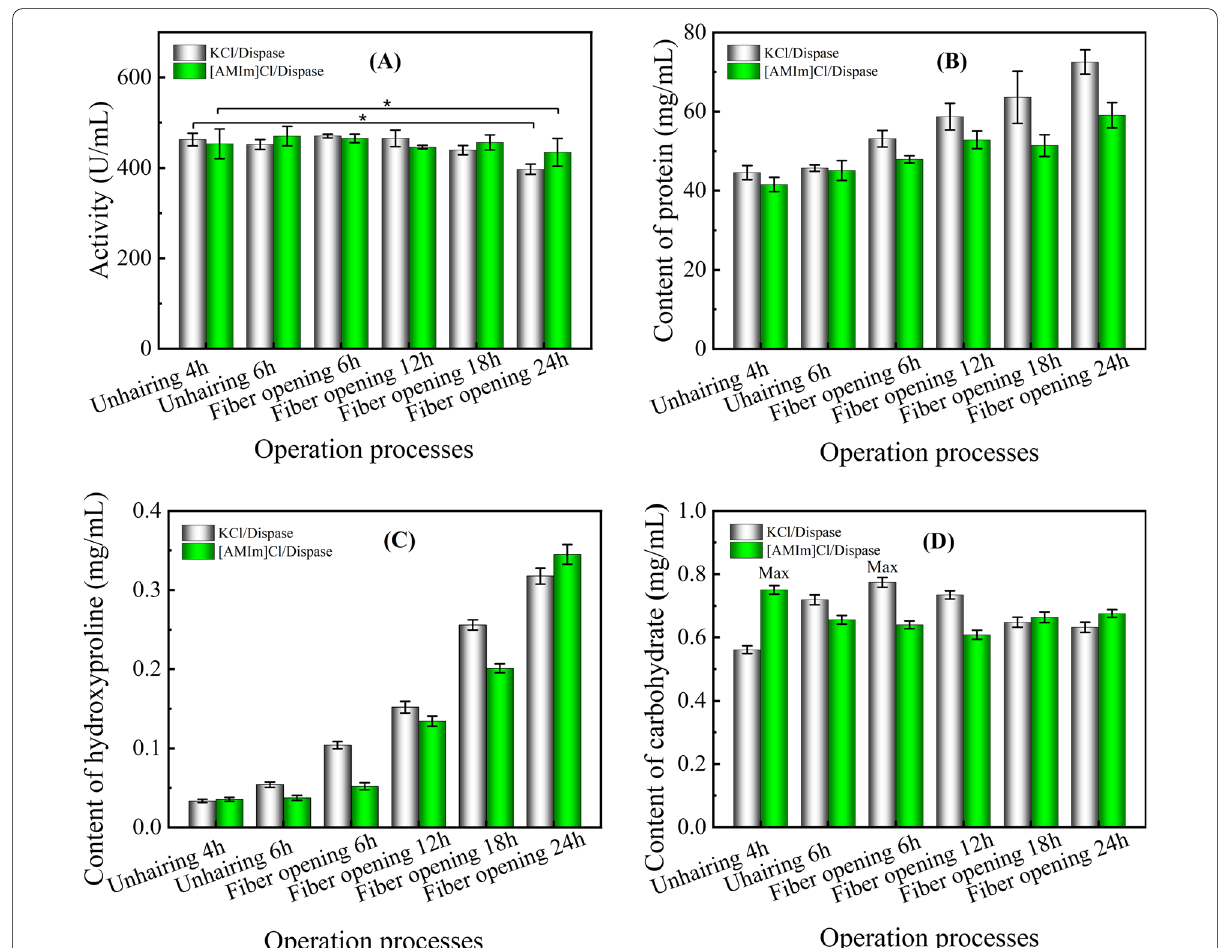
Fig. 2 Changes of dispase activity, protein contents, HYP contents and carbohydrate contents in wastewater during one-pot beamhouse; *Means not significant,